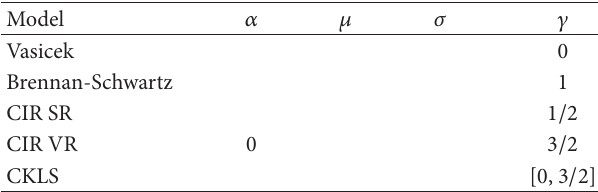
Table 1: Summary of the